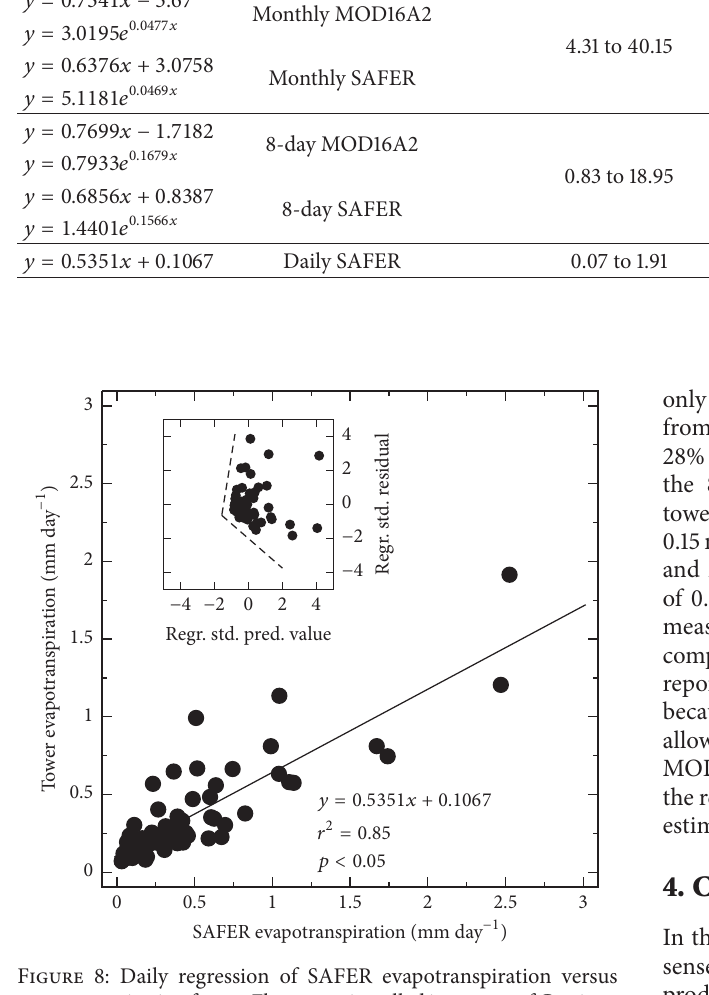
Figure 8: Daily regression of SAFER evapotranspiration versus evapotranspirationfromaFluxtowerinstalledinanareaofCaatinga at Embrapa Semi´arido, which is a research station of the state of Pernambuco, Brazil, for the year of 2012. In the insets, dispersion pattern of residuals is relative to the